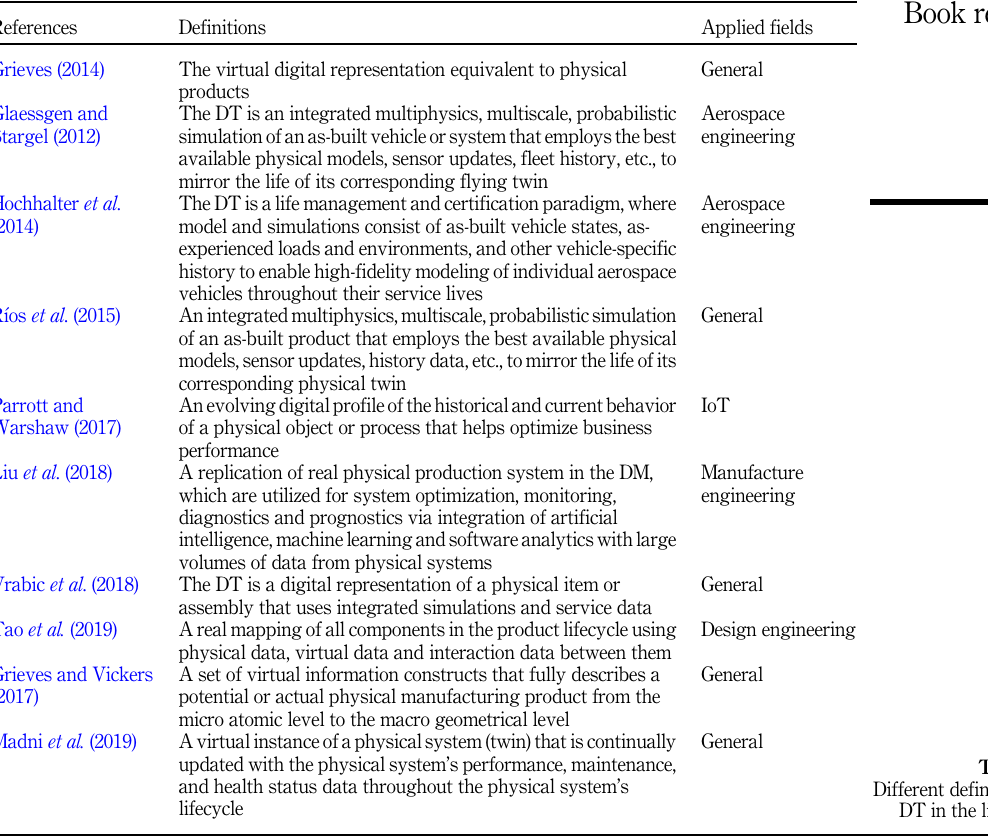
Table 1. Different definitions